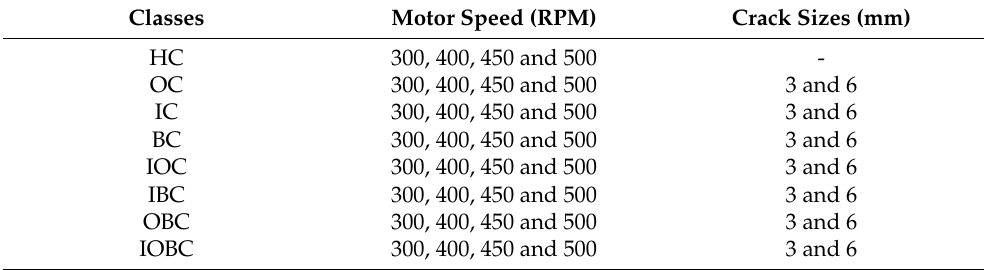
Table 1. AE UIAI-Lab bearing signal information.